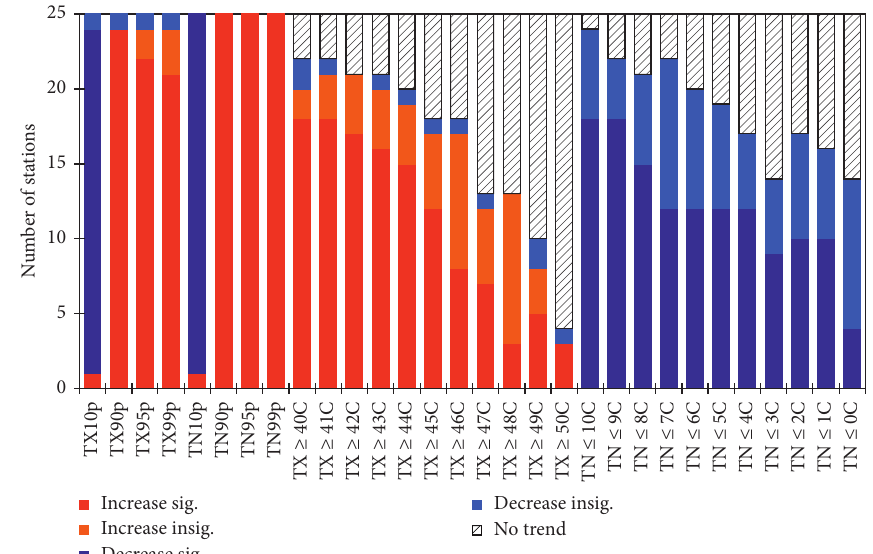
Figure 16: The increasing and decreasing linear trends in 30 extreme temperature events averaged for 25 stations over Saudi Arabia for the period 1978–2019. Stations, where linear trends cannot be calculated due to the nonoccurrence of the events, are shown as “No